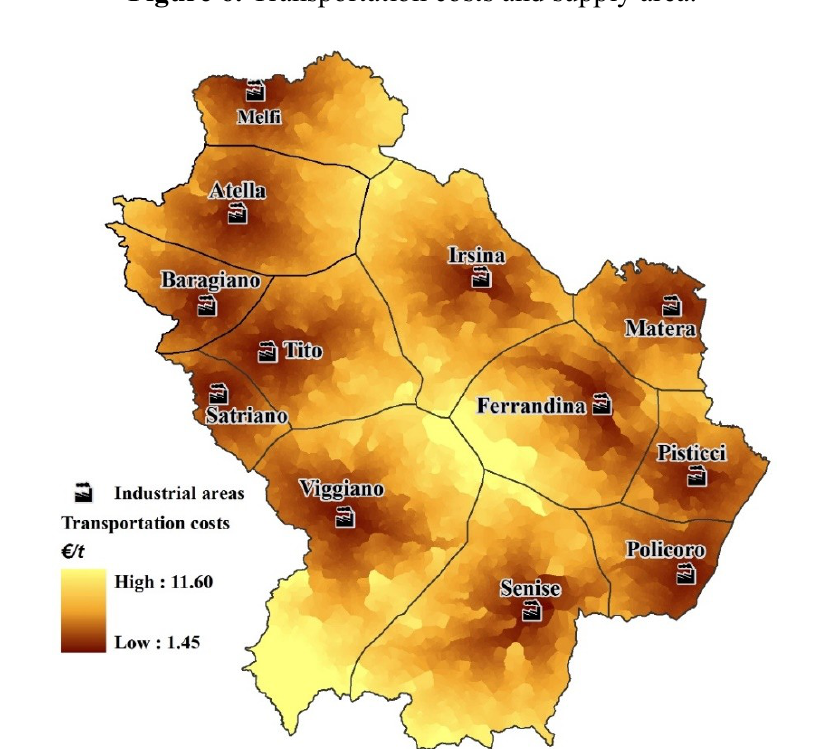
Figure 6. Transportation costs and supply